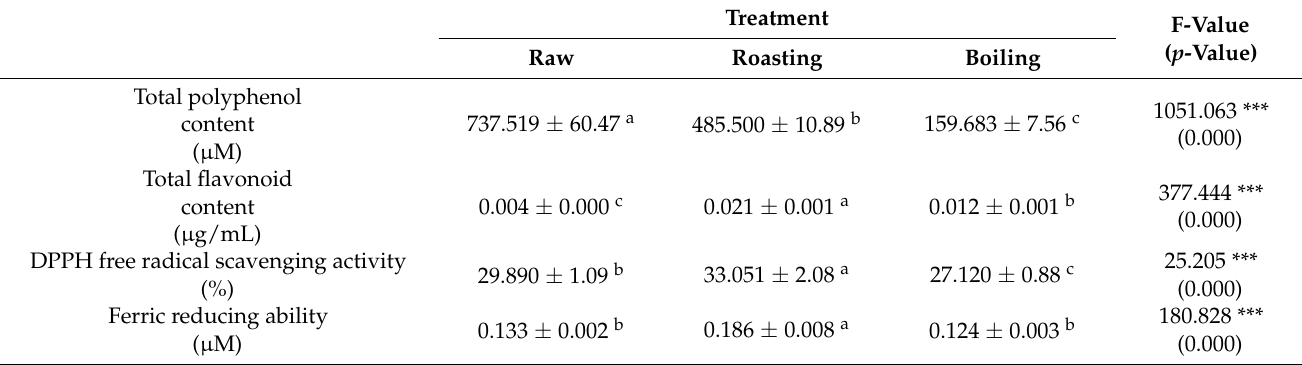
Table 2. Analyzed antioxidant effects of raw, roasted, and boiled Sacha